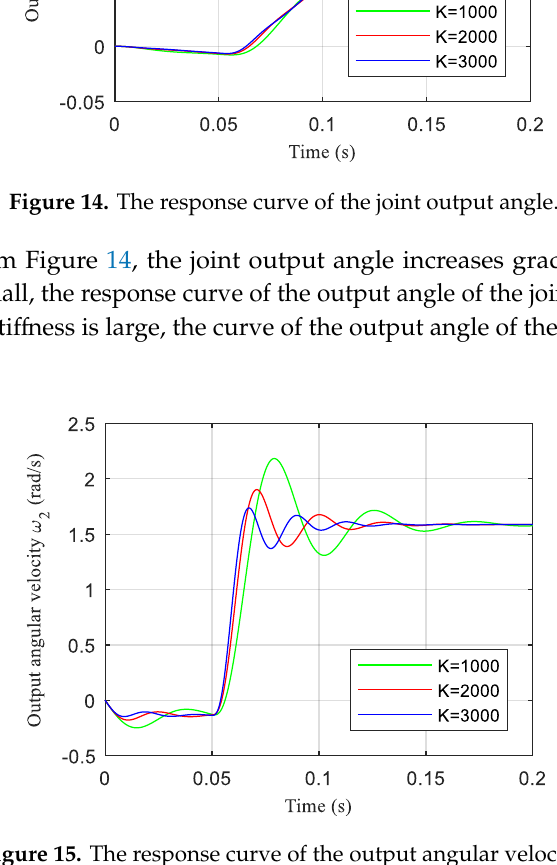
Figure 16. The response curve of the joint output torque. As can be seen from Figure 16 that the output torque of the joint increases from 0 until it eventually stabilizes, but the whole process shows great fluctuation. The lower the stiffness, the greater the fluctuation of the output torque. 4. Real-Time Dynamics Stiffness Control of SCM-VSJ To realize the real-time change of joint stiffness according to the needs of the environment during the movement of the robot, it is necessary to control the dynamic stiffness of the joint with variable stiffness. For the real-time control of dynamic stiffness of SCM-VSJ, this paper proposes an improved PID control method based on feedforward and feedback closed-loop. The block diagram of the control system is shown in Figure 17.